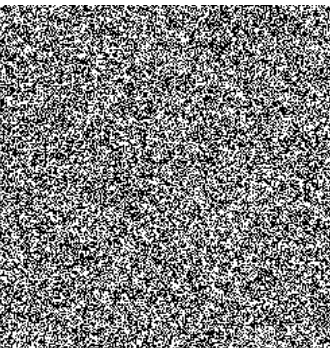
Figure 2. Example bitmap of 256 ∆ n i values from following 256-bit RSA-OTP random transac- tions (one value per row).